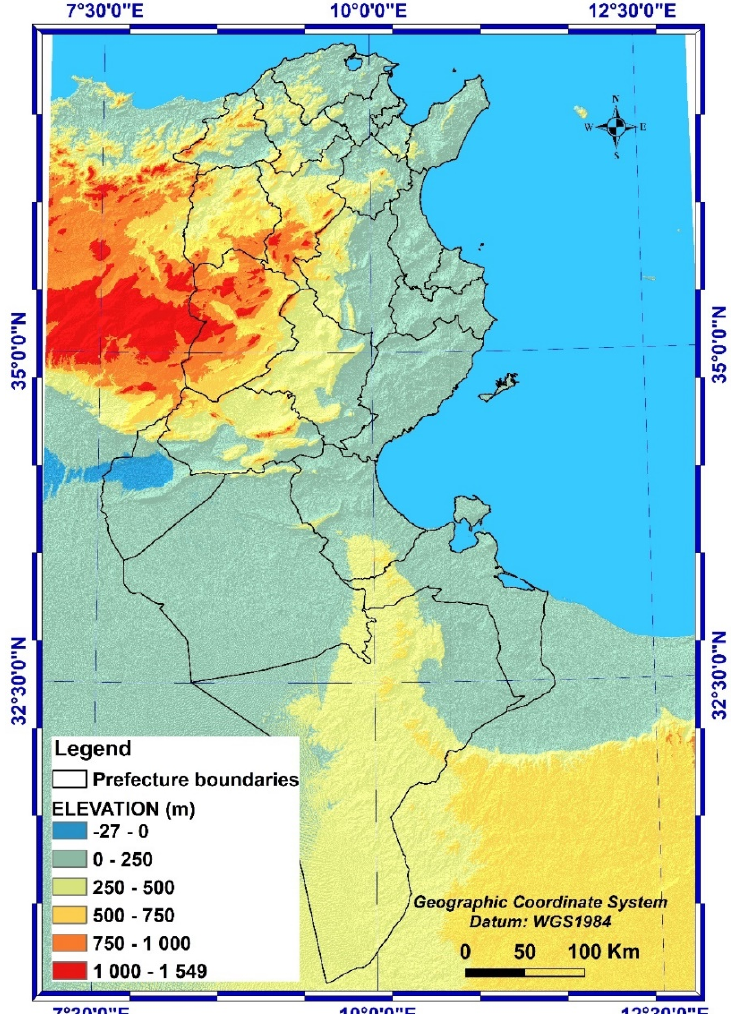
Figure 2. Distribution of altitudes in Tunisia generated from ASTER DEM data.